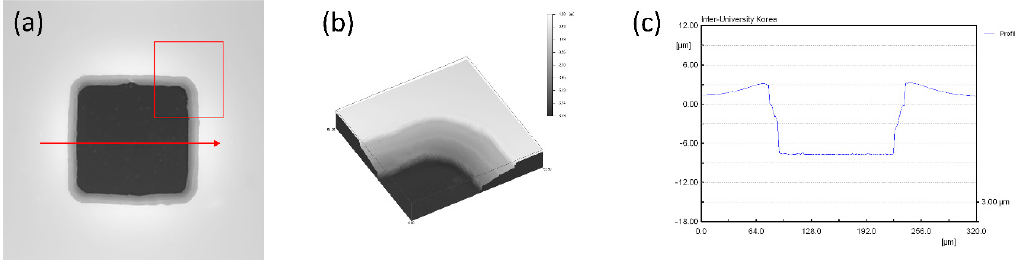
Figure 6. 3D rear profile images of plateau electrodes. ( a , b ) Wide field optical microscope images of an electrode. ( a ) The gray rectangle band shows the slope of the electrode. ( b ) An enlarged 3D projection of the region in the red rectangle of the image in ( a ). We can observe the gently sloping PDMS wall, which has an inclination angle of 40°. ( c ) 2D profile of the electrode obtained along the red line in ( a ). One side of the electrode is approximately 130 μ m, and the depth of the electrode is approximately 11 μ m.